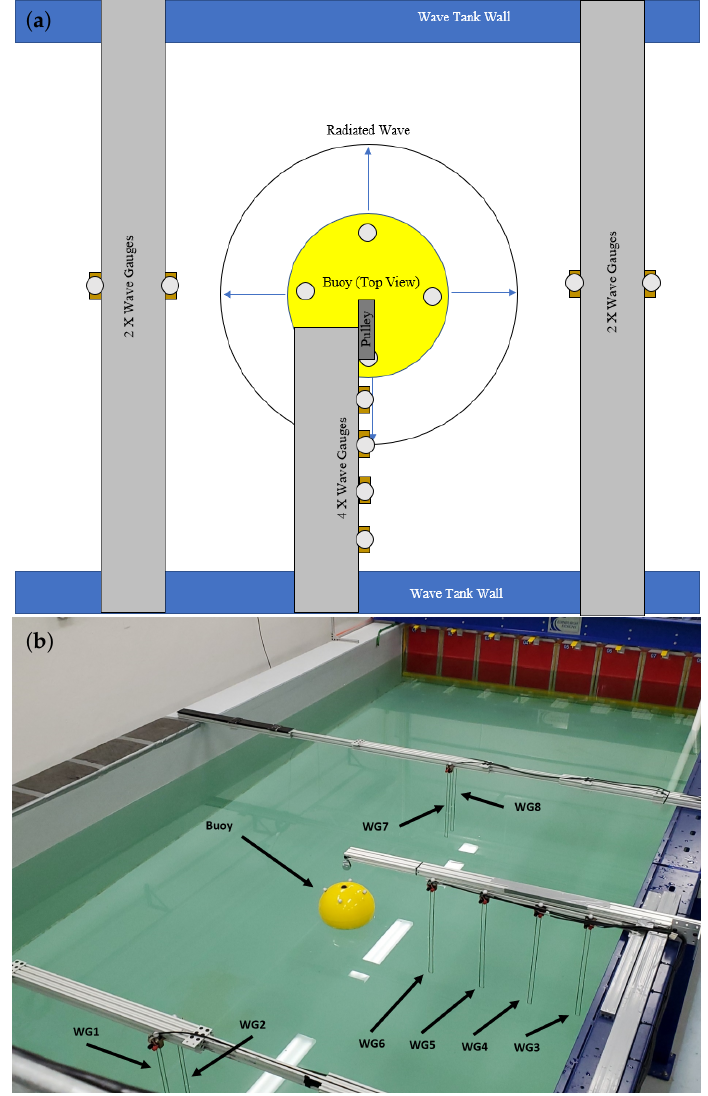
Figure 2. ( a ) Diagram of experimental setup (top–down view). ( b ) Annotated image of the experi- mental setup with assigned wave gauge